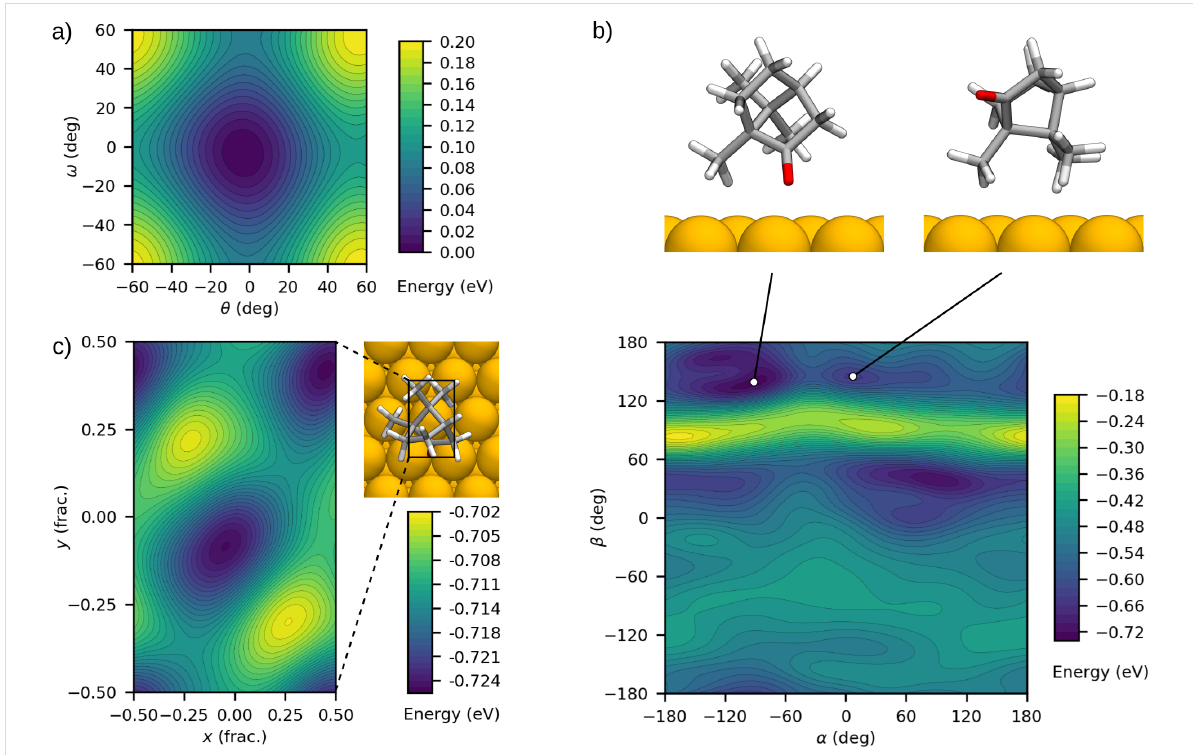
Figure 4: Energy landscapes from preparatory BOSS simulations. (a) θ – ω 2D cross section of the 3D PES in the camphor conformer search, featuring a single minimum and an energy barrier of 0.1 eV for methyl group rotation. (b) α – β 2D cross section of the 3D PES in the search for adsorp- tion orientation of camphor on Cu(111). The landscape features multiple local minima and a higher-energy region at β ≈ 90°. (c) PES of the 2D trans- lational x – y search of the adsorption site of camphor on Cu(111). The landscape has two identical minima, which agree with the translational symmetry in the orthogonal unit